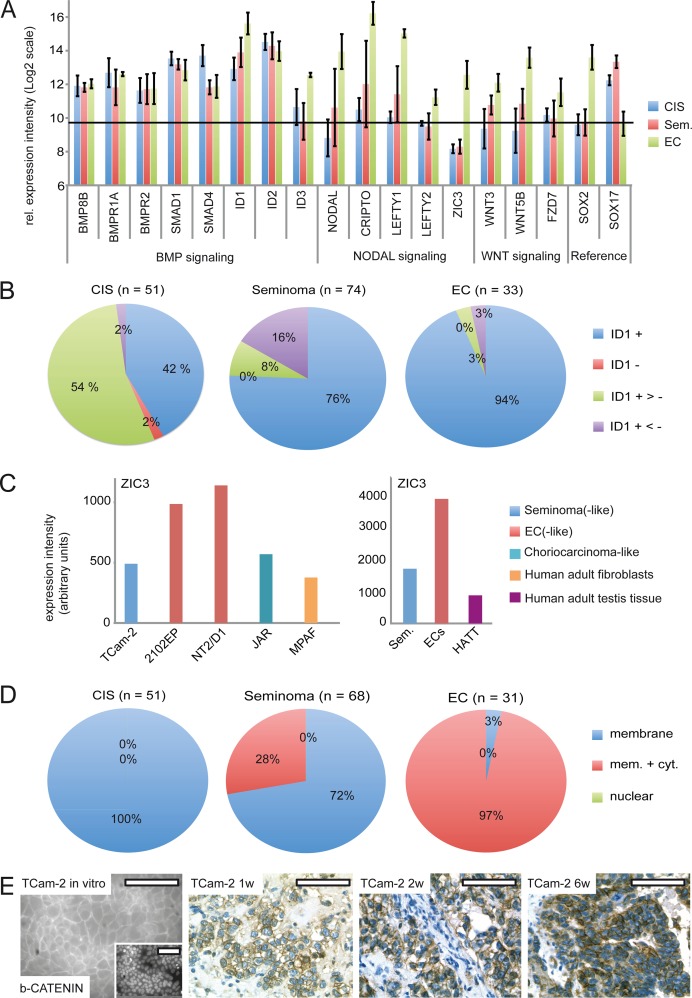
BMP, NODAL and WNT signaling in GCC tissues and cell lines.(A) cDNA microarray expression data of BMP, NODAL and WNT signaling-associated genes in GCC tissues. SOX2 and SOX17 were used to determine zero level of expression intensity (black line). (B) Pie diagrams summarizing ID1 IHC data of GCC-TMAs. Stainings were classified as ID1 positive (+), negative (-), mixed with much more positive than negative cells (+ >-) and mixed with much more negative than positive cells (+ <-). (C) ZIC3 protein levels in indicated GCC cell lines and tissues. (D) Pie diagrams summarizing beta-CATENIN IHC data of GCC-TMAs. Beta-CATENIN staining was classified as membraneous (m), cytoplasmic (c) and nuclear (n). (E) IF /IHC staining of beta-CATENIN in in parental and xenografted TCam-2 cells (1, 2 and 6 weeks). Scale bar: 100 μm.